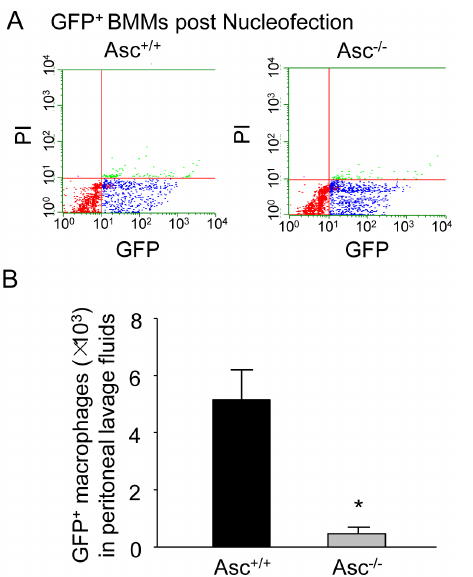
Figure 9. Macrophage migration invivo is attenuated by Asc- deficiency. (A) GFP-expressing Asc + / + and Asc 2 / 2 BMMs were obtained by Nucleofection of BMMs with GFP-encoding plasmids. Representative dot plots from flow cytometry analysis show the GFP expression and cell viability (PI) in Asc + / + and Asc 2 / 2 BMMs post Nucleofection with GFP plasmids. (B) GFP-expressing Asc + / + or Asc 2 / 2 BMMs were intravenously injected in Asc + / + mice with Zymosan A- induced peritonitis. The numbers of GFP + macrophages in peritoneal lavage fluids of Asc + / + mice were quantified and compared. * P , 0.05 vs . Asc + / + BMMs